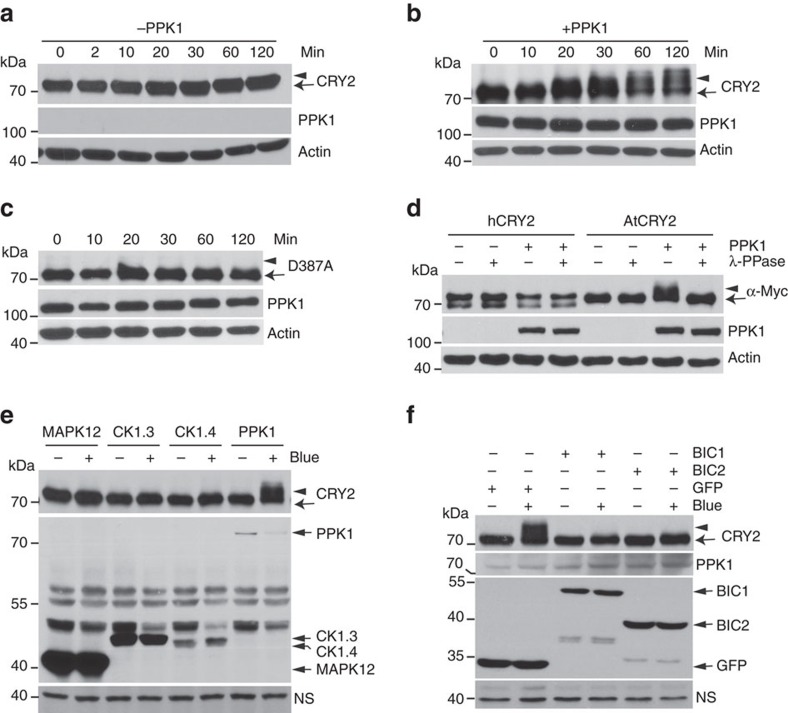
Immunoblot analyses of the substrate specificity of PPKs.(a-c) HEK293T cells expressing CMV::Myc-CRY2 (a,b) or chromophore-deficient CMV::Myc-CRY2D387A (c) in the absence (a) or presence of the co-expressed CMV::Flag-GFP-PPK1 (b,c) were exposed to blue light (30 μmol m−2 s−1) for the indicated time. CRY2 and PPK1 were detected by the anti-CRY2 or anti-Flag antibodies, respectively. (d) HEK293T cells expressing CMV::Myc-hCRY2 or CMV::Myc-AtCRY2 in the absence (PPK1−) or presence of CMV::Flag-GFP-PPK1 (PPK1+) were exposed to blue light (30 μmol m−2 s−1) for 2 h. Lysates were treated with (λ-PPase +) or without λ-PPase (λ-PPase −), and analysed by immunoblots probed with the anti-Myc (α-Myc) or anti-Flag (PPK1) antibody, respectively. (e) HEK293T cells co-expressing CRY2 and PPK1 or indicated kinases are analysed as in a. (f) HEK293T cells co-expressing CMV::Myc-CRY2 and CMV::Flag-PPK1 in the presence of CMV::GFP-BIC1, CMV::GFP-GFP-BIC2, or CMV::GFP were kept in the dark (Blue −) or exposed to blue light (30 μmol m−2 s−1, Blue +) for 1 h, and analysed by immunoblots probed with anti-CRY2 (CRY2), anti-Flag (PPK1) or anti-GFP (BIC1, BIC2 or GFP) antibody, respectively.